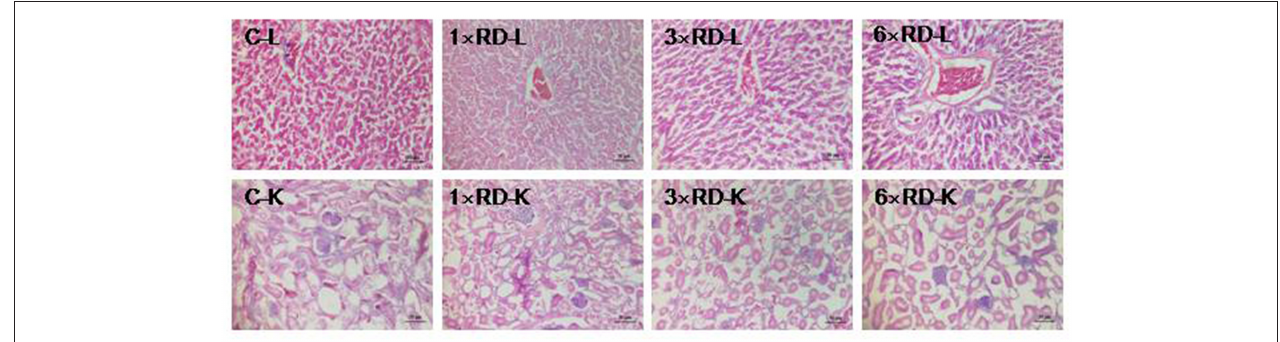
FIGURE 4 | Histopathological analysis of organs in the control (C) and three QHP-treated groups (1 × recommend dose, 1 × RD; 3 × recommend dose, 3 × RD; 6 × recommend dose, 6 × RD) after 14-day administration (H&E stained); livers (L, 100 × ); kidney (K, 100 × ). Scale bar = 50 µ m.